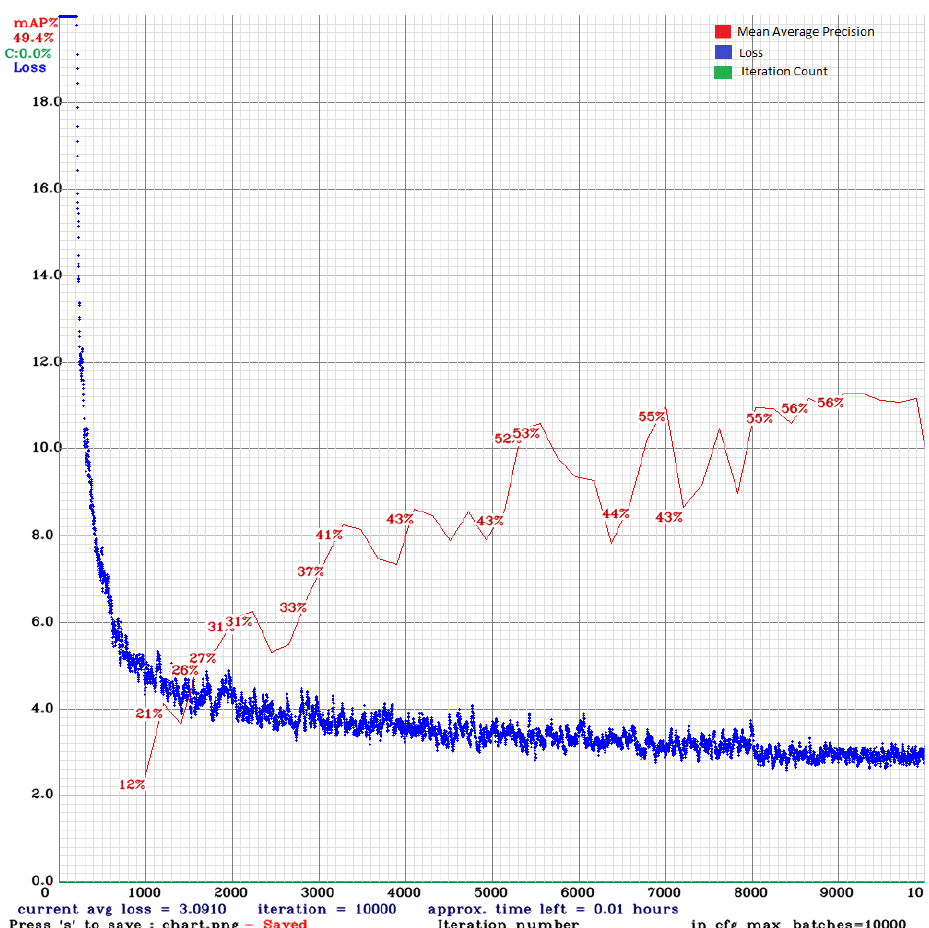
Figure 2. Tiny-YOLOv4 model mAP @ 0.5 (red), loss (blue), iterations (green). The real-time detection results of the Tiny-YOLOv4 model are shown in Figure 3. The model predicts the potato weeds correctly and efficiently with a high confidence score.